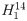
CpG frequencies for each dinucleotide position for first order nullomers (H114) in eleven different species: panel a) Human, Chimpanzee and Gorilla (yellow, dark yellow and light orange, respectively), panel b) Rat and Mouse (orange and light red, respectively), panel c) Opossum, Bovine, Goat and Lemur (red, dark red, light brown and brown, respectively), panel d) Chicken, and Rabbit (very dark brown and black, respectively).In panel e all the species are reported together.